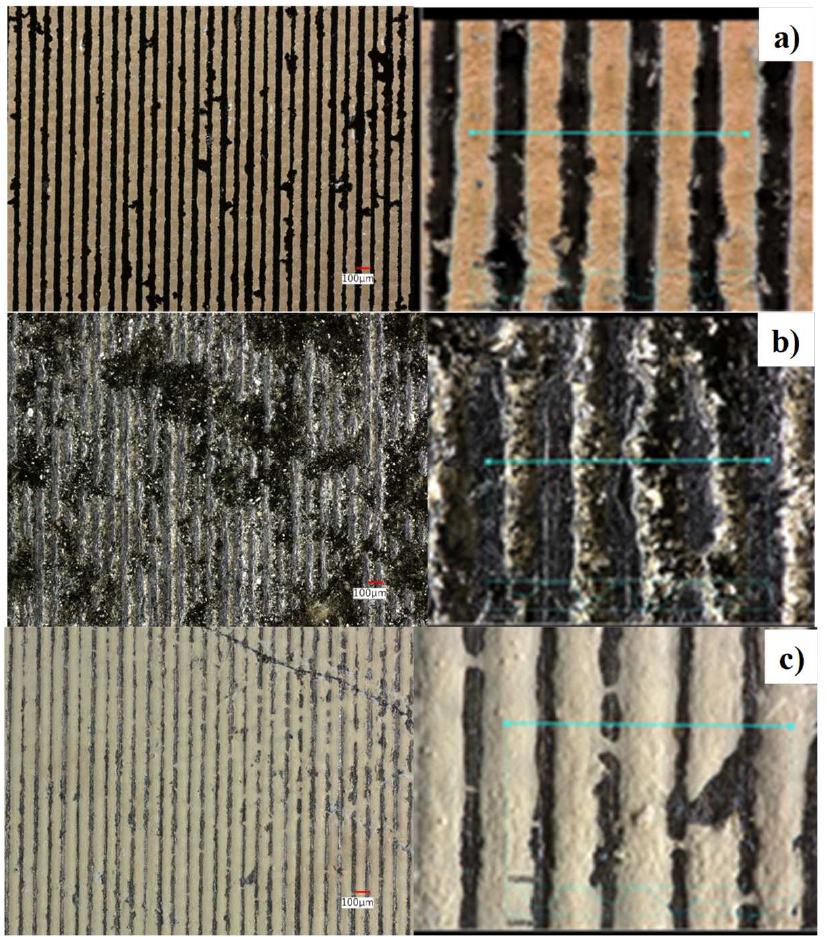
Figure 9. The measured surface profile of three micro-grooved VGS specimens after plasma oxidation etching at RT for 7.2 ks. ( a ) VGS-1 by P = 100 Pa, ( b ) VGS-2 by P = 50 Pa, and ( c ) VGS-3 by P = 70 Pa.